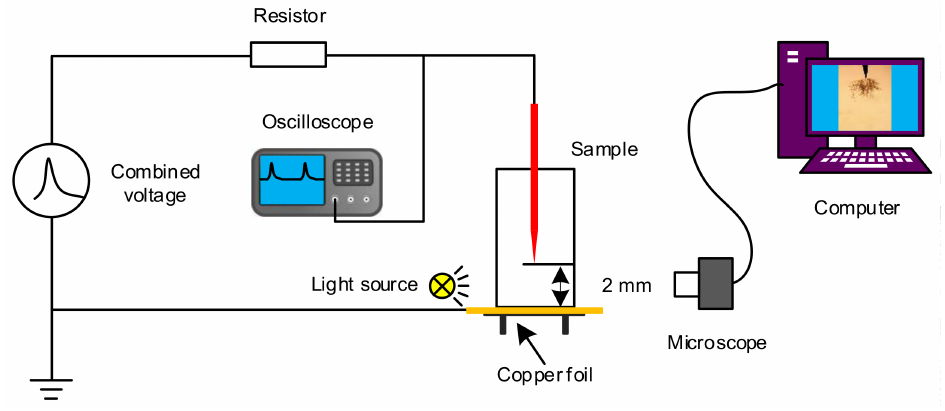
Figure 1. Schematic diagram of experimental